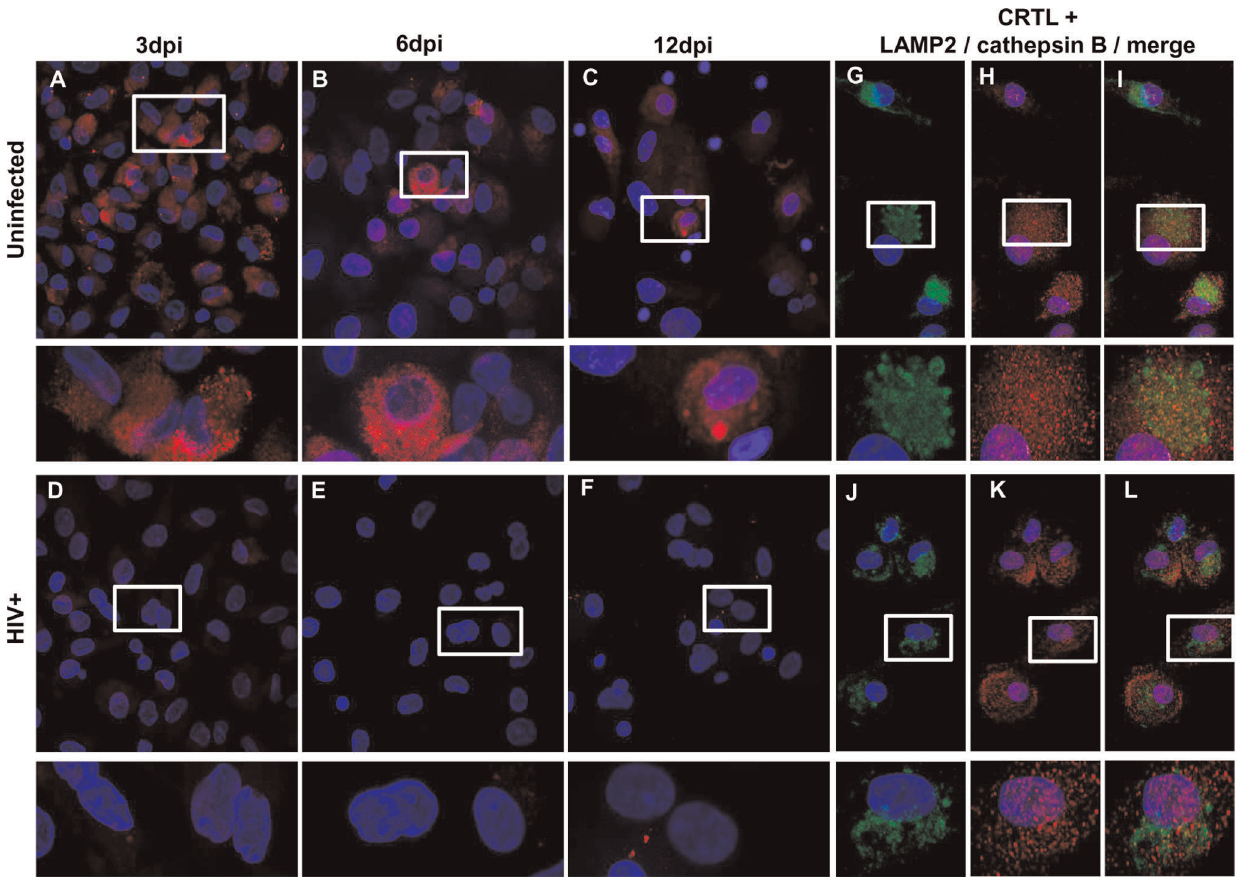
Figure 5. Cathepsin B is released from lysosomes in HIV-infected MDM. To analyze the lysosomal localization of cathepsin B, cathepsin B and LAMP2 immunoreactivity were assessed by in situ PLA (Duolink) in uninfected and HIV-infected MDM 3, 6 and 12 dpi. Cathepsin B colocalizes with LAMP2 in uninfected MDM (A, B and C; top panels). However, little colocalization is seen in HIV infected MDM (D, E and F; bottom panels). The presence of individual proteins was determined by immunofluorescence staining (G, H, I, J, K and L). As seen in the right panels both, cathepsin B (red) and LAMP2 (green) are expressed in uninfected (G, H, and I) and HIV-infected (J, K, L) cells. The results presented in this figure are representative of 3 experiments.